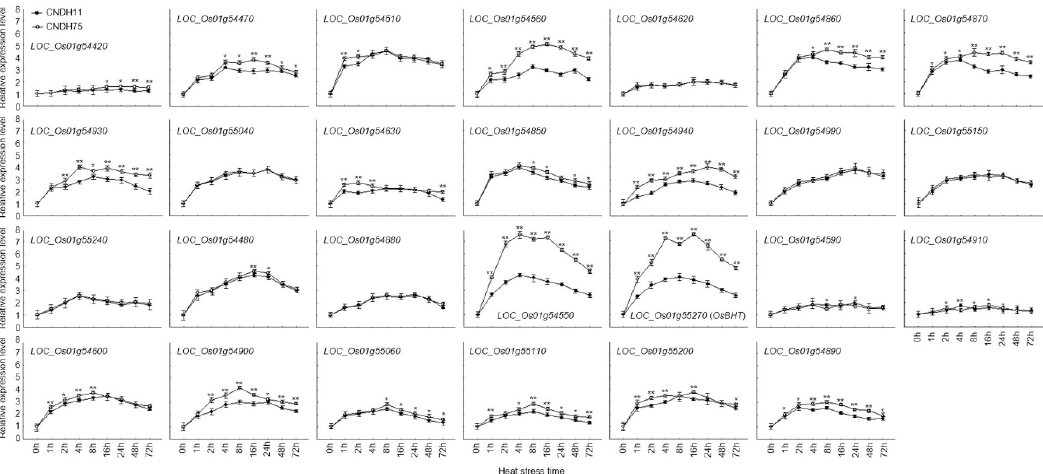
Figure 4. Analysis of relative expression levels of candidate genes in high-temperature susceptible and tolerance lines. Expression analysis of candidate genes in rice at the booting stage exposed to 42 ◦ C heat stress in a growth chamber, with rice leaf sampled at di ff erent time points at 0 h, 1 h, 2 h, 4 h, 8 h, 12 h, 16 h, 24 h, 28 h, and 72 h. Data are presented as the mean ± SD ( n = 3), Student’s t -test. CNDH11 is the high-temperature susceptible line, and CNDH75 is the high-temperature tolerance line. * Significant at the 0.05 level; ** significant at the 0.01